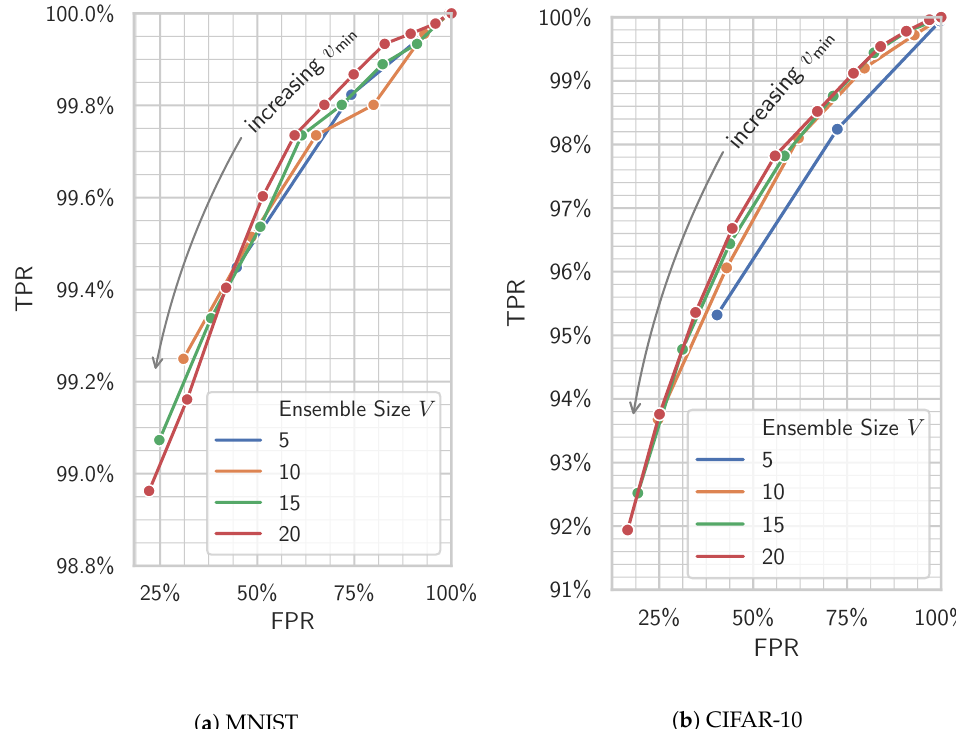
Figure 4. Analysis of the detection performance with the randomized tolerance ensemble. ROC curves (TPR vs. FPR, where TP = “correctly detected natural input” and FP = “adversarial input misdetected as natural”) are obtained after varying the minimum majority size v min , i.e., if the number of majoritarian votes v agree in the ensemble is greater than v min , the input is considered authentic (positive), and otherwise, adversarial